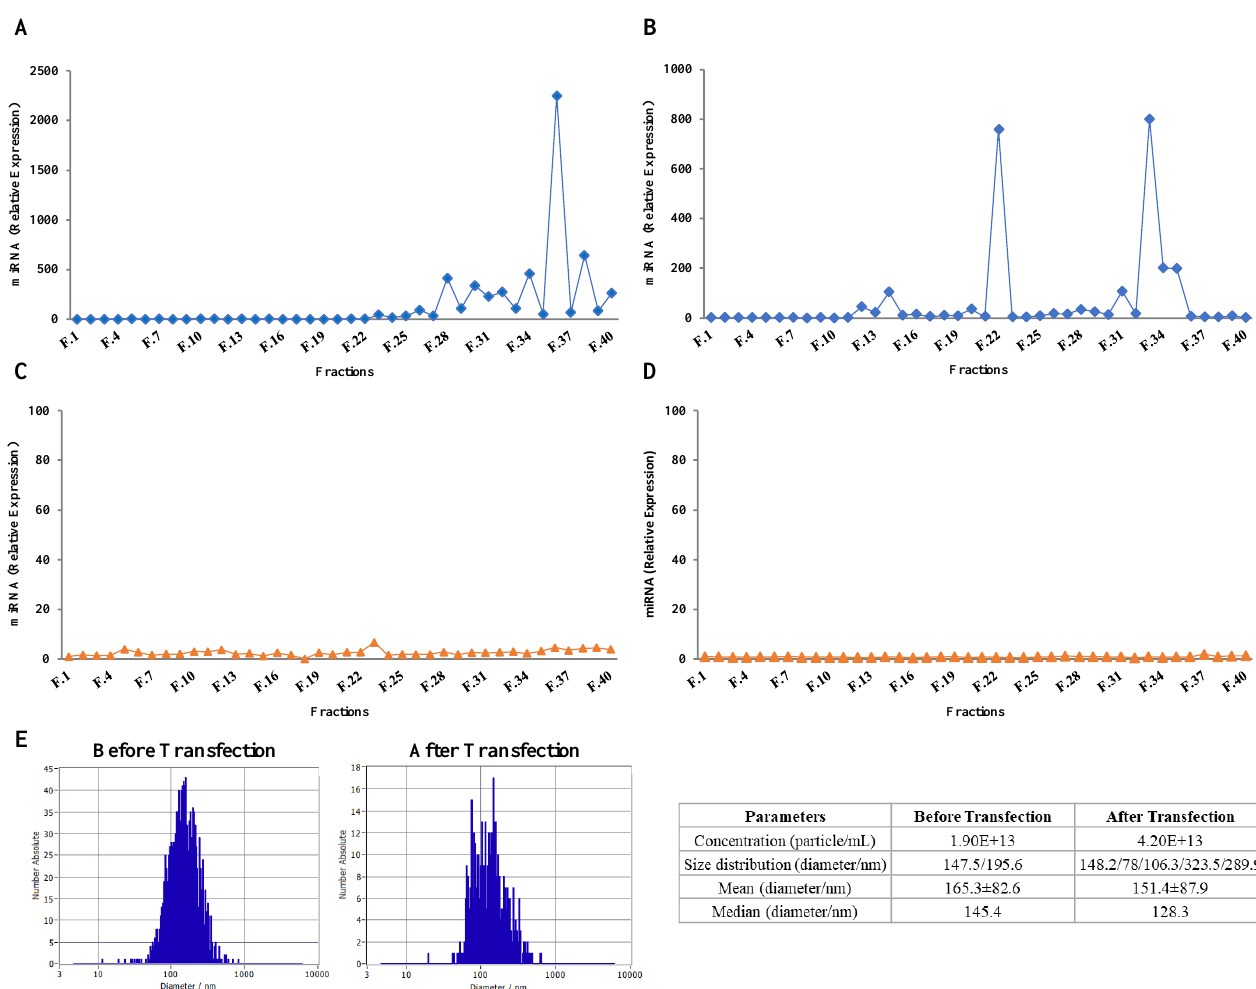
Figure 2. Mimic hsa-miR-148a-3p elution profile (RT-qPCR expression analysis). miRNA alone ( A ) or combined with lipofectamine after SEC ( B ). miRNA alone ( C ) and miRNA combined with lipofectamine after one ultracentrifugation step followed by SEC ( D ). Nanoparticle tracking analysis (NTA) before and after exosome transfection ( E